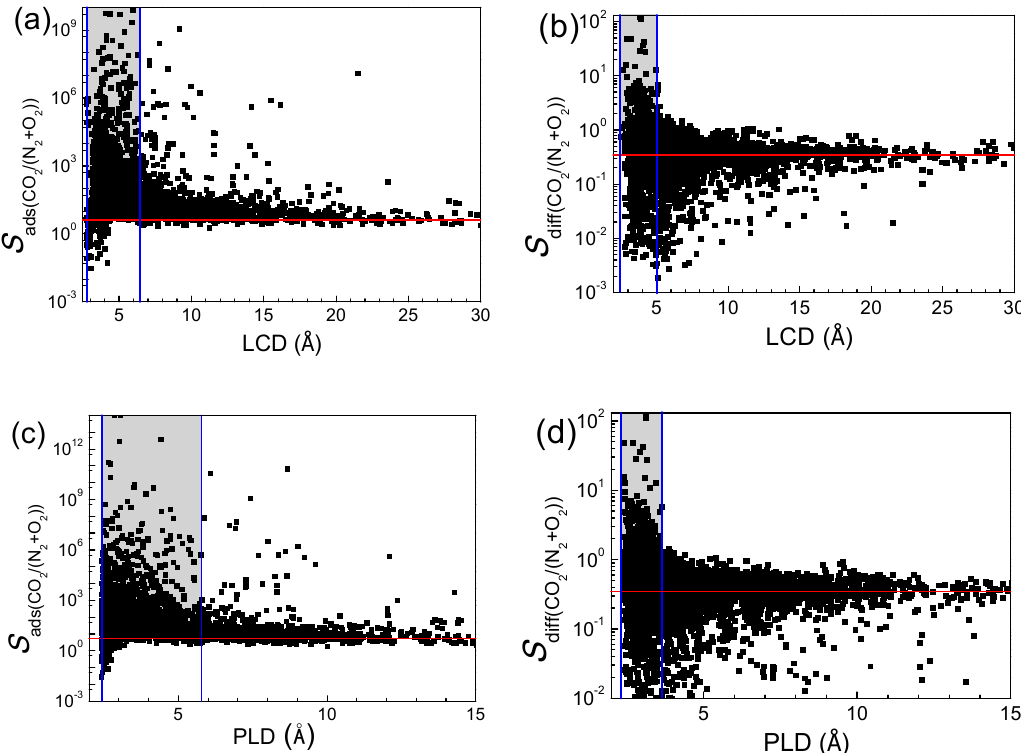
Figure 1. The relationships of ( a ) S ads (CO2/N2+O2) and ( b ) S diff (CO2/N2+O2) with ( c ) largest cavity diameter (LCD) and ( d ) pore-limiting diameter (PLD).